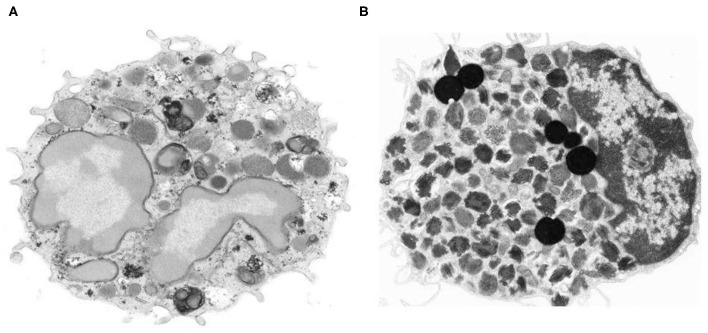
Morphologic and ultrastructural differences between human basophils and mast cells. (A) Human peripheral blood basophil shows irregular blunt surface processes and a polylobed nucleus with condensed chromatin pattern. The cytoplasm contains large-membrane bound secretory granules filled with electron dense particles and/or finely granular material (11) X 21,500. (B) Isolated human lung mast cell has a narrow surface fold and single lobed nucleus with partially condensed chromatin pattern. The cytoplasm is filled with a large number of membrane-bound secretory granules that have an extremely variable ultrastructural pattern (16, 17). The cytoplasm also contains six non–membrane-bound spherical lipid bodies that are larger than secretory granules, are osmophilic and do not contain scrolls (16, 17) X 14,000. Photos kindly provided by Ann M. Dvorak and reproduced with permission from Marone et al. (18).